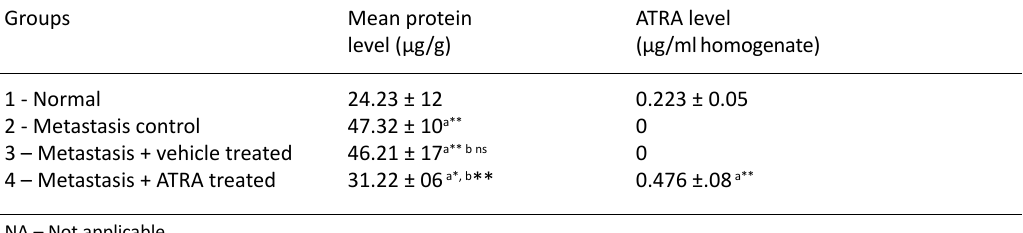
table 2. The total protein level in lung tissue